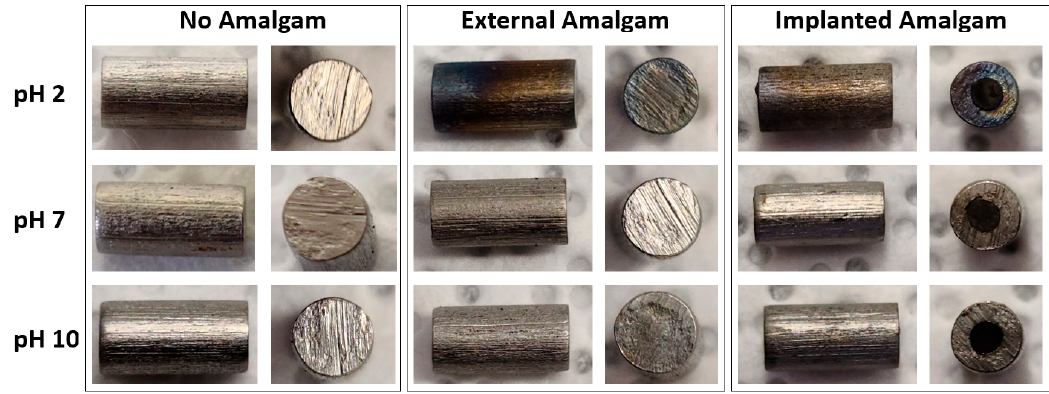
Figure 1. Optical images of Ti rods immersed in pH 2, pH 7, and pH 10 solution.